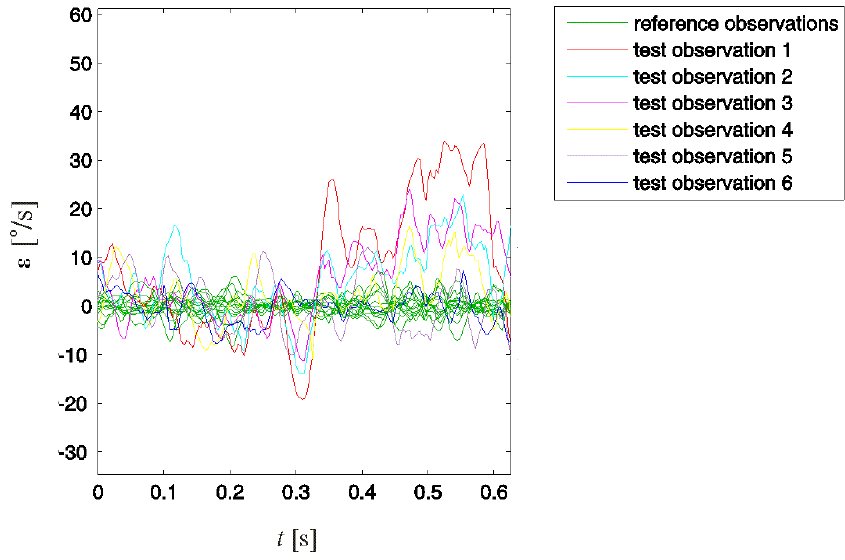
Figure 8. Acceptable and test observation residual deviations in time domain. Acceptable deviations residuals represent deviations in properly performed swings attributed to noise and/or different artefacts. The deviation residuals for test observations 1–5, for which improper motion was detected, considerably exceed acceptable deviations